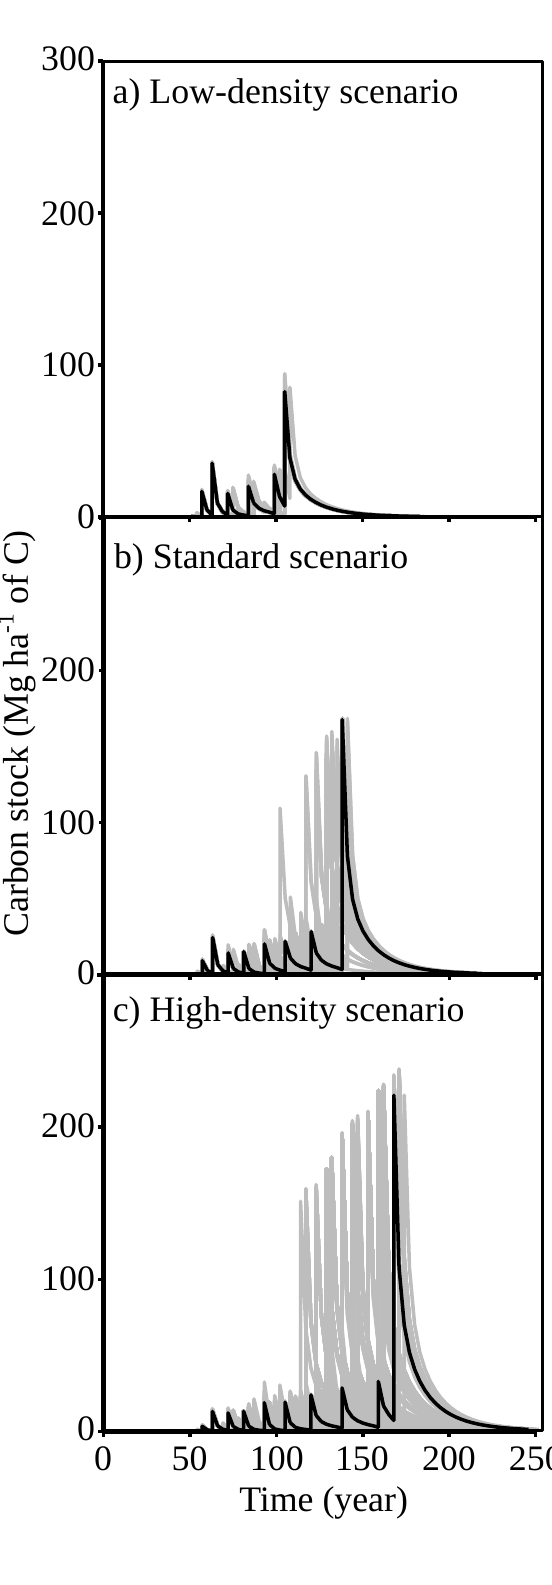
Figure 4. Evolution of the carbon stocks in the HWP carbon pool for three different management scenarios (black: without wind damage; gray: realizations with stochastic wind